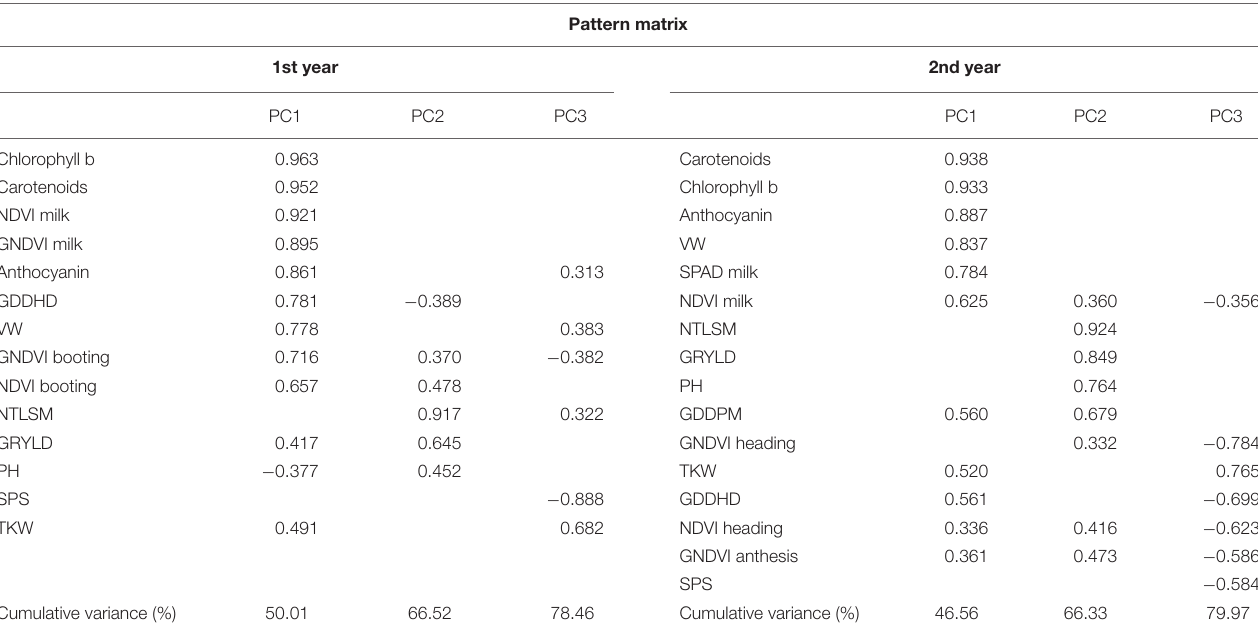
TABLE 8 | Pattern matrix of the PCA analysis.